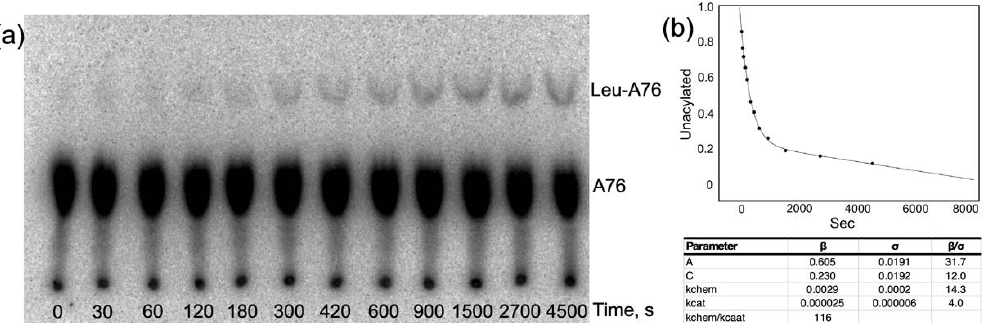
Figure 7. Analysis of a more finely divided time course for LeuAC aminoacylation, showing and excellent fit to a bi-phasic time course. The LeuAC used here is the MBP fusion. ( a ) TLC separation of acylated leucyl- 2′ , 3′ AMP as a function of time. ( b ) Time course in A fitted to Equation (1).